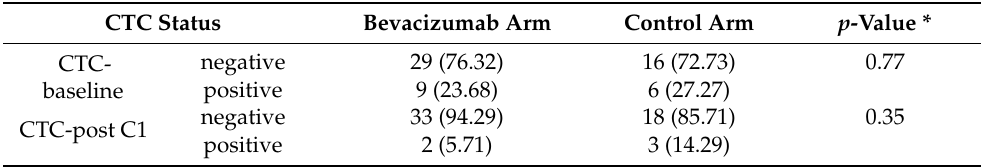
Table 2. CTC status at baseline and after one cycle of treatment. Data are expressed as N (%); *: rank-Wilcoxon’s